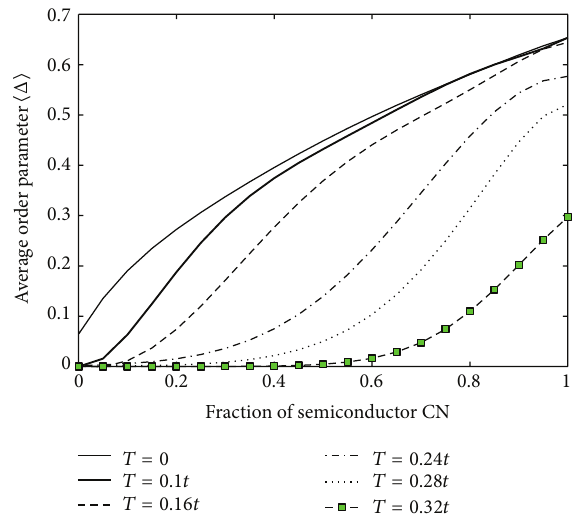
Figure 1: Spatially averaged superconducting order parameter ⟨Δ⟩ (in units of 𝑡 ) as a function of the fraction of doped semiconducting nanotubes 𝑎 at different temperatures.